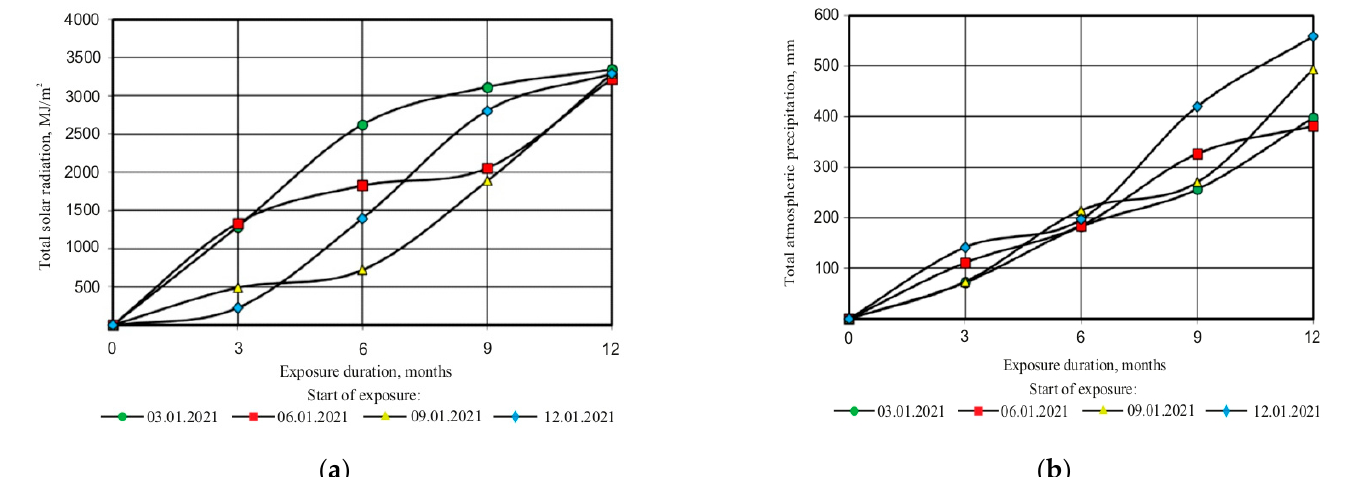
al ‐ 45M relative to the common time axis.